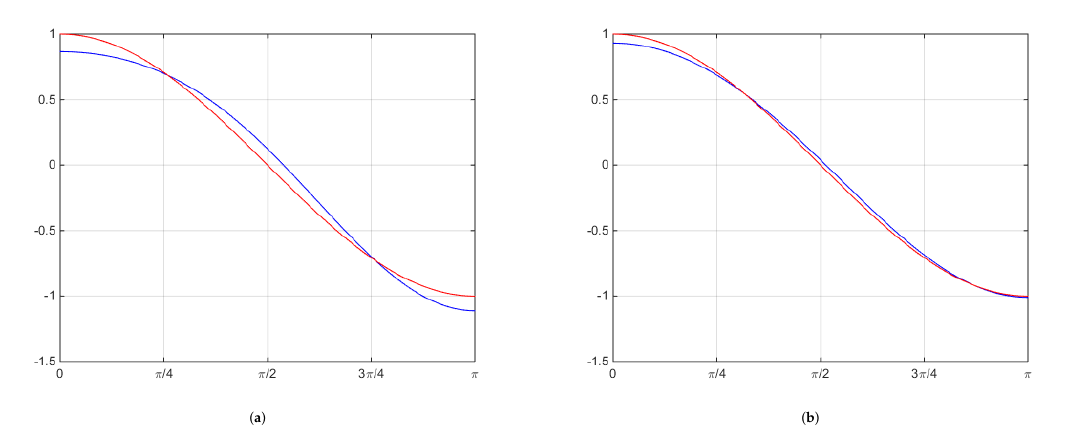
Figure 2. Reconstructed potential (blue) and exact potential (red) p ( x ) = cos ( x ) ( a ) δ = 0.1 ( b ) δ = 0.05.